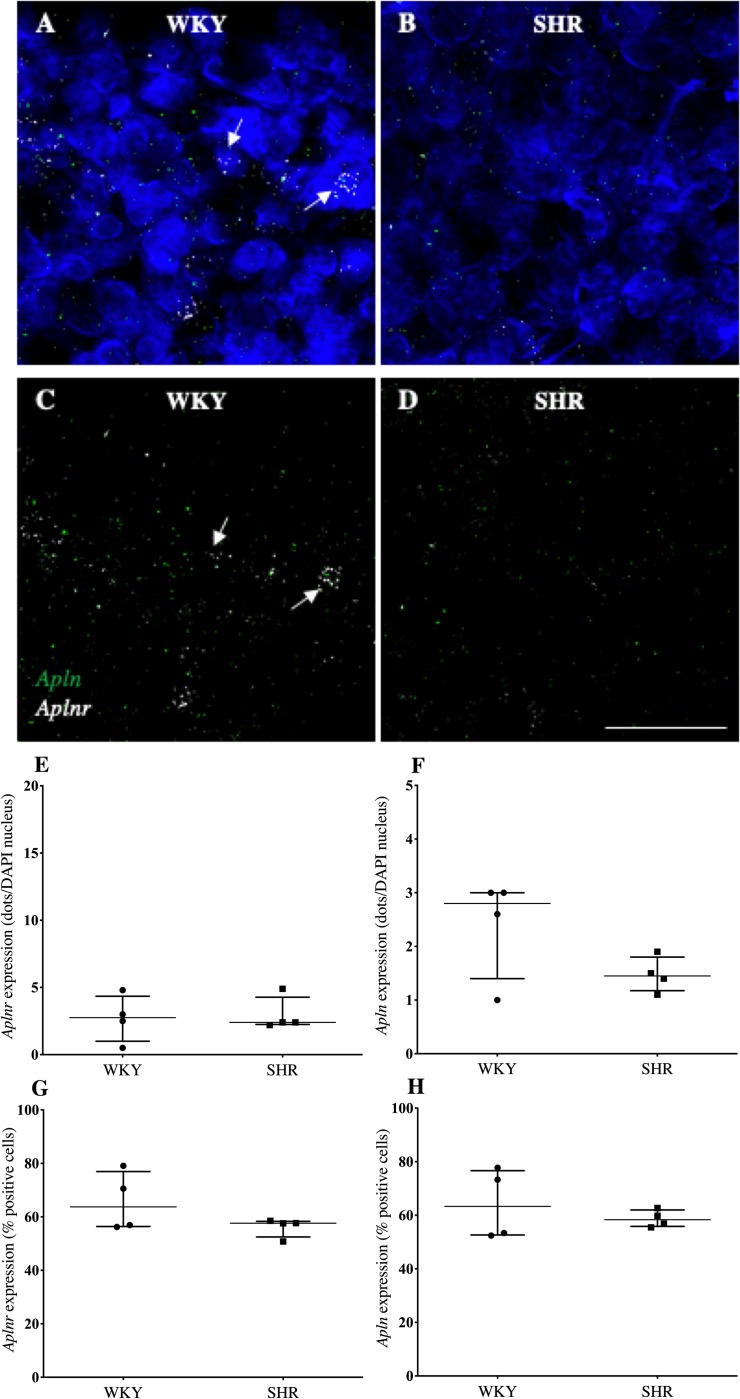
Aplnr and apln expression in the AP of WKY rats and SHRs.(A-D) Representative fluorescent images showing expression of aplnr and apln in the AP of WKY rats (A and C) and SHRs (B and D). DAPI: blue, aplnr: white, apln: green. DAPI removed from C and D to highlight distribution of mRNA. Cells with a high relative abundance of aplnr are arrowed. Scale bar = 50μm. (E-H) Graphs showing gene expression as a function of dots/DAPI nuclei or percentage positive cells for aplnr (E and F) and apln (G and H) mRNA. n = 4/group. Data is median [IQR].